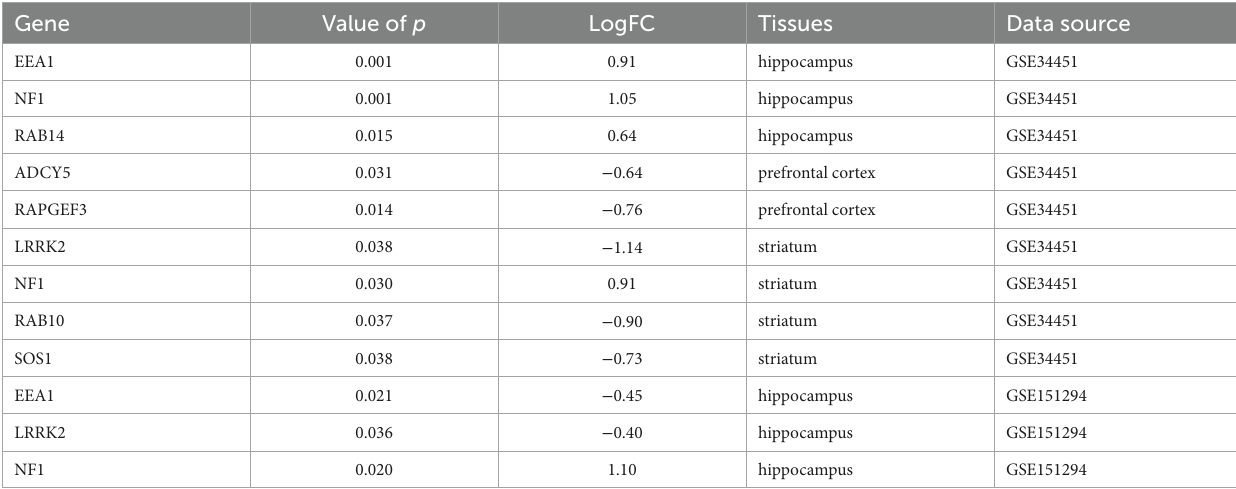
TABLE 2 Key gene